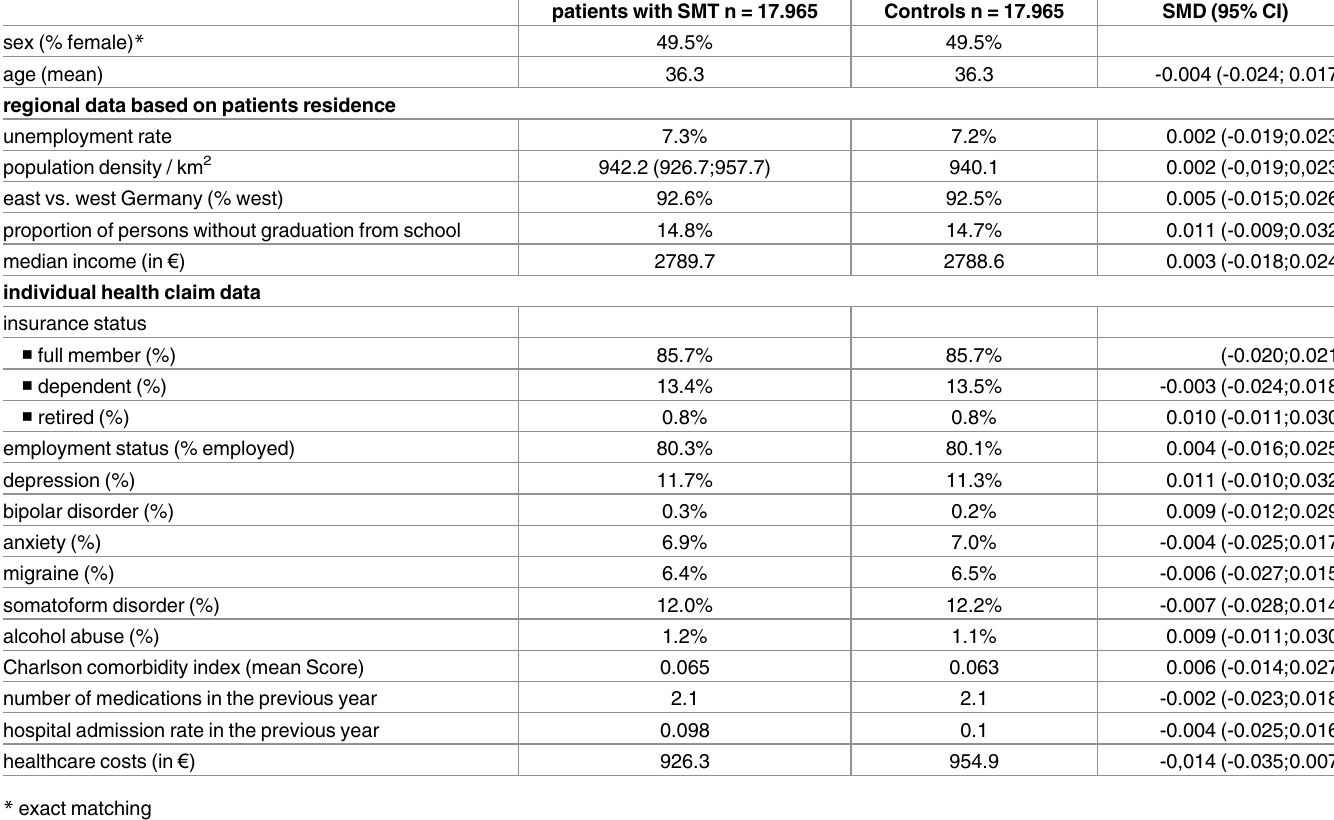
Table 1. Description of the matching variables of the intervention and control group.